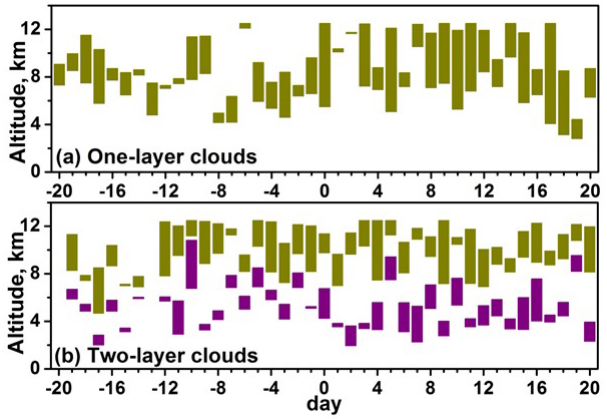
Figure 13. Composite (2006–2016) variations of mean vertical lo- cations (base and top) and thicknesses of one-layer clouds and two- layer clouds observed with respect to the date of monsoon arrival over the Gadanki location. Zero on the x axis indicates the date of monsoon arrival over the Gadanki